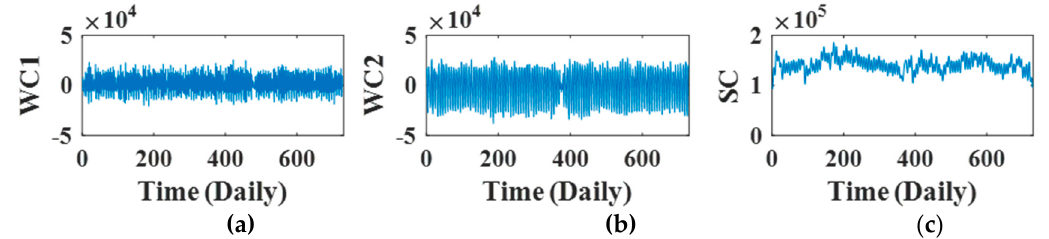
Figure 4. Maximum overlap discrete wavelet transform (MODWT) coefficients constructed using lag 1 of the Toowoomba campus dataset with the optimum wavelet (scaling) filter ( fk 8 ) and wavelet level 2. WC ( a, b ) and SC ( c ) represent the wavelet and scaling coefficients, respectively.